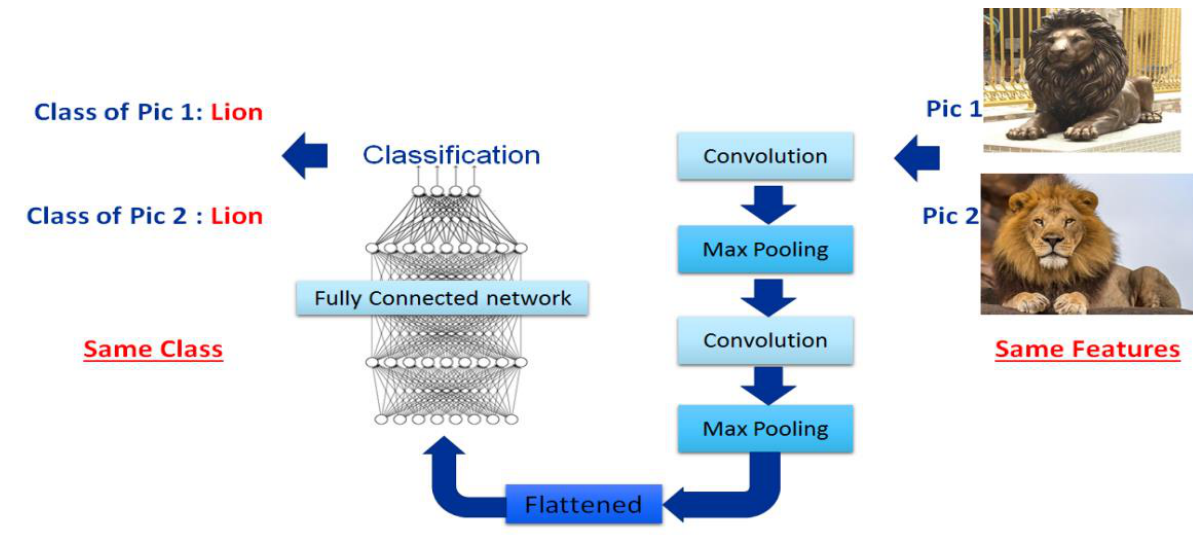
Figure 2 . Same features lead to recognize a same class by a pure Neural Network approach.